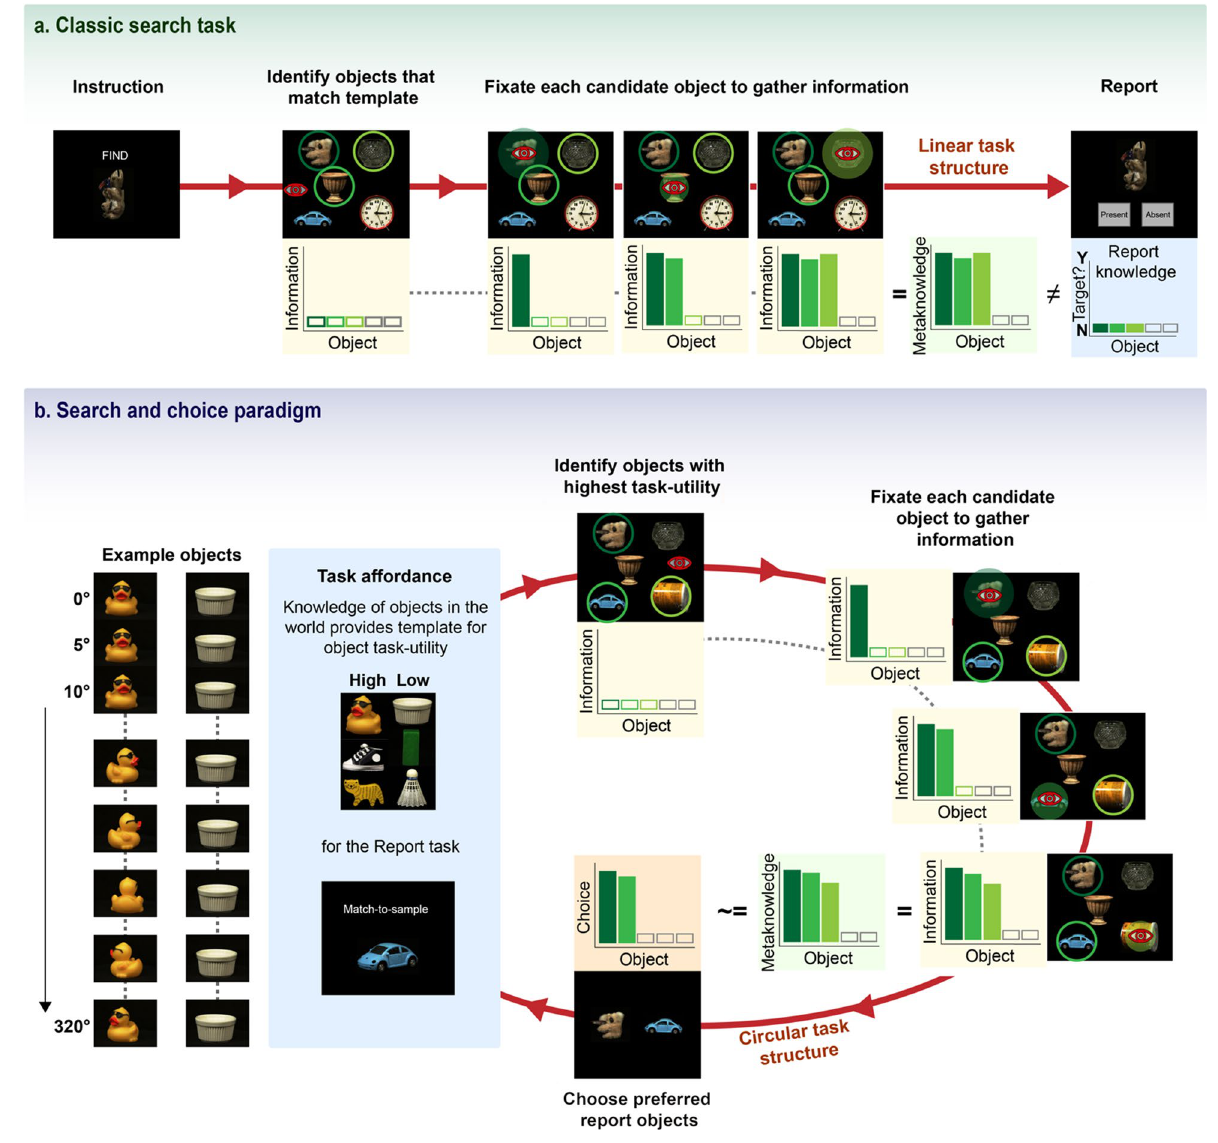
Figure 1. Comparison of classic search paradigms with the search and choice paradigm used in this study. ( a ) Example of a classic search paradigm, with a linear task structure: a search task is completed based on a template or instruction, but metaknowledge about the amount of information gathered for fixated objects is not necessary for, or probed in, the perceptual report task. ( b ) The framework for this experiment. In this framework, the constraints of the match-to-sample perceptual report task influence how information is sampled, and how this information is subsequently used. Here, the task structure is circular, because the requirements of the perceptual report task directly feed into the task affordance at the outset of the task: there are no specific search templates or instructions given at the start of each trial, rather the knowledge of the requirements of the eventual report task feed into the task affordances. The stimulus set comprises 577 unique objects, each with 360° viewpoints. Some objects, like the duck, are very easy to distinguish as they are rotated; others, like the ramekin, are very difficult to discriminate from one rotation to the next. Potential high-utility objects (in this case, those that are easier/ more discriminable for the match-to-sample perceptual report task) are selected to be saccade targets; with each fixation, evidence about the orientation of the fixated object is gathered, along with a meta-representation of the degree of (un)certainty around this orientation: this can be roughly equated to perceptual confidence. Participants have to choose which objects they would prefer to report: they should choose those that they are more confident about (have more information about), and which, given the hypothesised search strategy, should also be easier to report. In this paradigm, the information gathered with each fixation is directly probed in the match-to-sample perceptual report